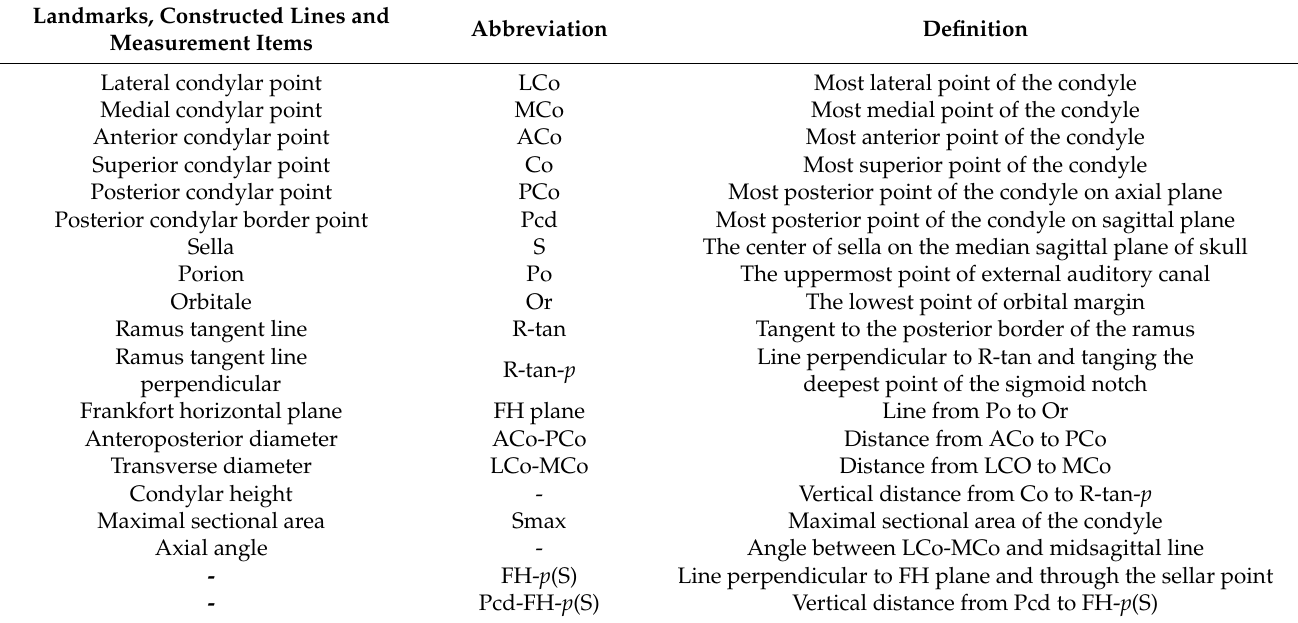
Table 1. Definition of landmarks and measurement